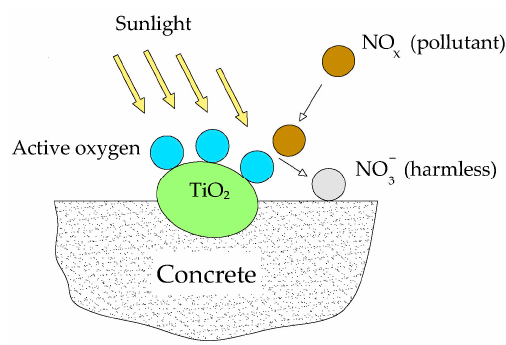
Figure 3. Schematic representation of photocatalytic concrete.